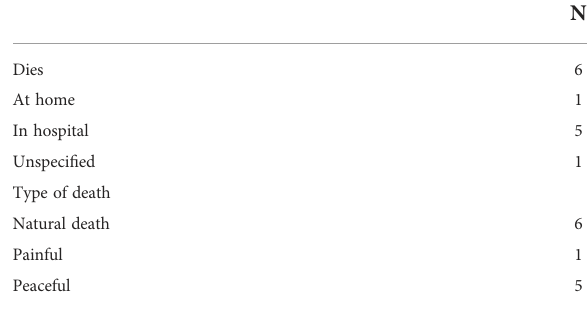
TABLE 2 Characteristics of Cancer in the